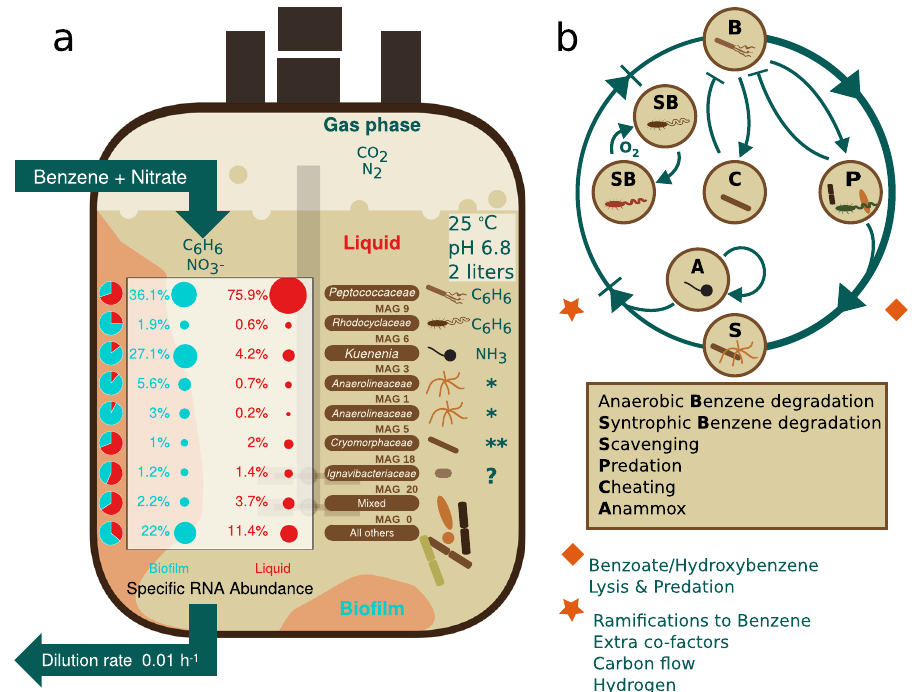
Fig. 5 Schematic representation of the anaerobic benzene degrading microbial community in a 15-year old bioreactor, highlighting the dominant niches with their hypothetical interactions. a Characteristics of the 7 dominant MAGs concerning expression levels in bio fi lm and liquid along with their preferred energy sources are shown. Pie charts show the ratio of relative speci fi c RNA abundance between bio fi lm (teal) and liquid (red) with the corresponding values. Values and symbols in teal are derived from samples of the bio fi lm phase, those in red from samples of the liquid phase. The terms bio fi lm and liquid phases are explained in the Methods section. Note that most expression in both phases is derived from anaerobic benzene degradation by a member of the Peptococcaceae , while that of anaerobic ammonia oxidation by Candidatus Kuenenia stuttgartiensis is highest in the bio fi lm. (* - Lysate) Anaerolineaceae potentially using extracellular peptides and proteinaceous polymers derived from lysed cells as carbon and energy source. (**) Cryomorphaceae potentially using secondary metabolites derived from anaerobic benzene degradation. (?) prevalent carbon and energy source unknown. b The outer ring represents the main carbon fl ow between the primary consumer B and the other members of the community. The diamond symbol indicates mechanisms or metabolic left-overs with which B feeds the other members of the community and the rhombus symbol indicates what it gets in return. We hypothesize that the community members interact with each other via syntrophy, scavenging, predation or even cheating. Those interactions are represented with the arrows that indicate transition and bar-headed arrows to specify inhibition — in or within the outer ring. The arrow that returns back to A represents the autotrophic niche, which is occupied by Anammox for free energy transduction and carbon fi